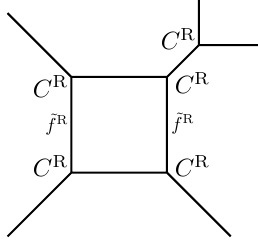
Figure 20 . Web diagram of SU (2) + 1 F denoted by C R and ˜ f R